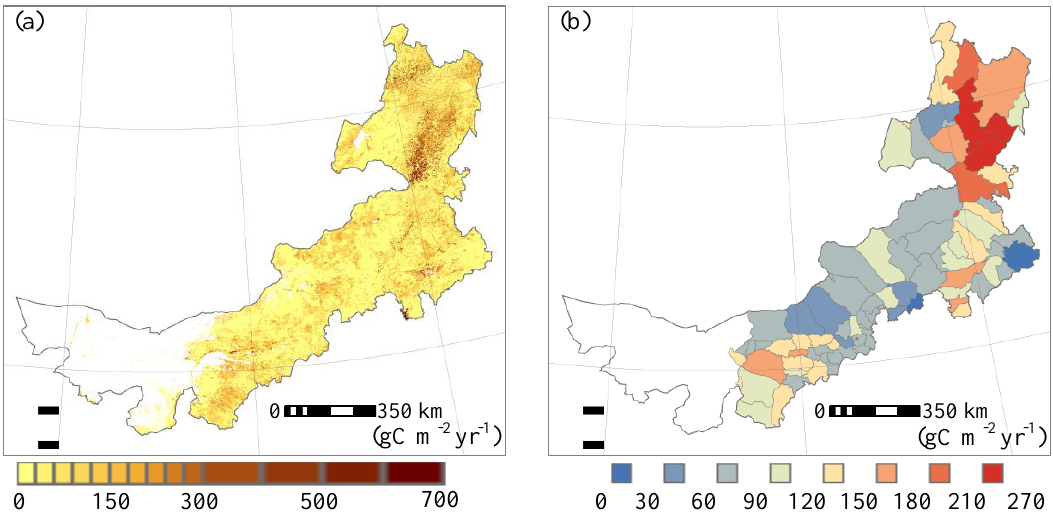
Figure 3. Distribution of reduced carbon uptake (RCU) at the pixel scale (with RCU mean = 58.9 ± 2.3 gC m − 2 yr − 1 ) and the aggregated administrative unit level. ( a ) Temporally averaged reduced carbon uptake (RCU) (2001–2018), and ( b ) Zonal average at the administrative-unit scale.